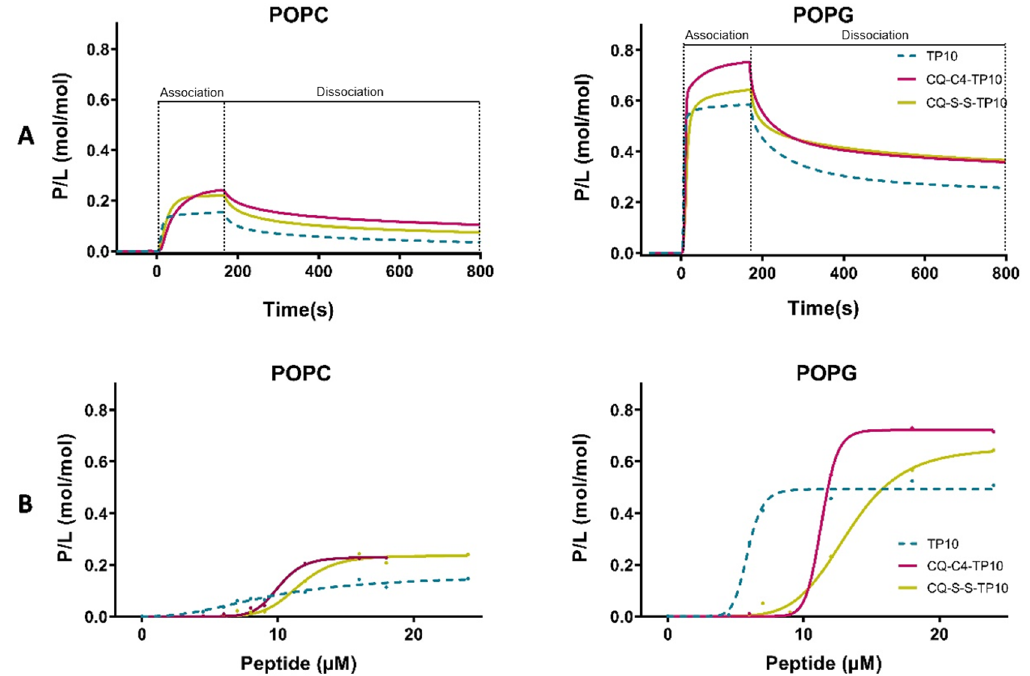
Figure 2. Binding of TP10 and CQ-TP10 conjugates to lipid model membranes as monitored using surface plasmon resonance (SPR). ( A ) Sensorgrams obtained upon injection of 16 µM TP10 (dotted lines) and its CQ conjugates over 1-palmitoyl-2-oleoyl-sn-glycero-3-phosphocholine (POPC) or 1-palmitoyl-2-oleoyl-sn-glycero-3-phosphoglycerol (POPG) bilayers deposited onto an L1 chip surface. Analytes were injected for 180 s (association phase) and lipid dissociation was monitored for 600 s (dissociation phase). Signal was normalized to peptide-to-lipid ratio (P/L; mol/mol) as detailed in Materials and Methods; ( B ) Dose-response curves for each lipid bilayer. P/L obtained at the end of the association phase (t = 180 s) was plotted as a function of peptide concentration in solution.